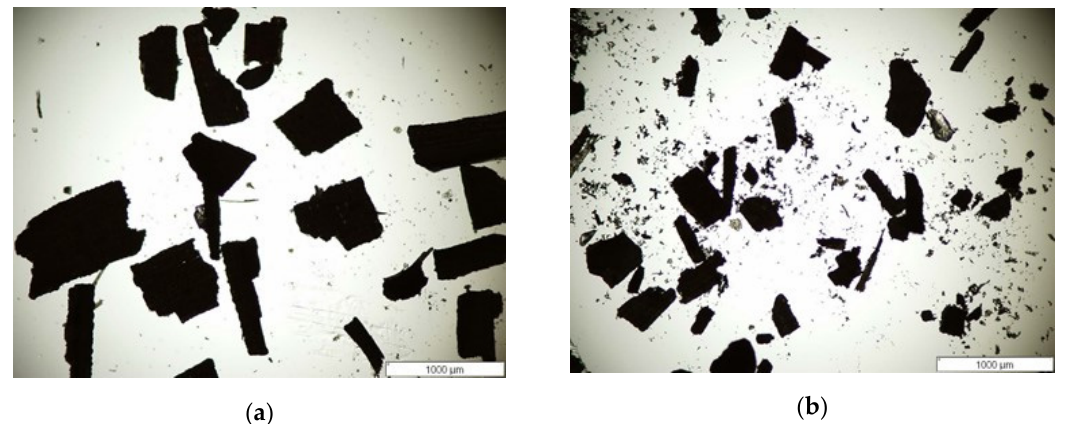
Figure 1. Optical micrographs of screened ( a ) < 1 mm and ( b ) < 0.5 mm rice hull particles (40 × , scale bar 1000 µm).